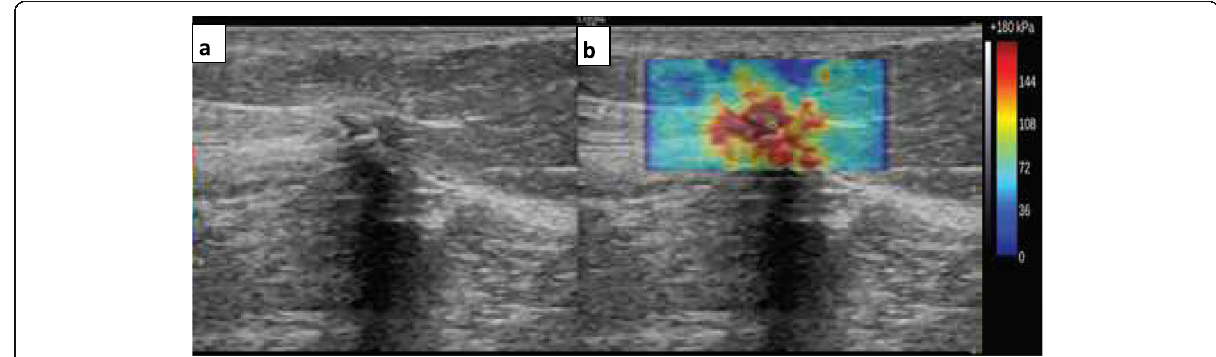
Fig. 3 A 60-year-old patient with Lt. breast mass proved to be invasive ductal carcinoma “ grade I ” on histopathological examination. Left ,